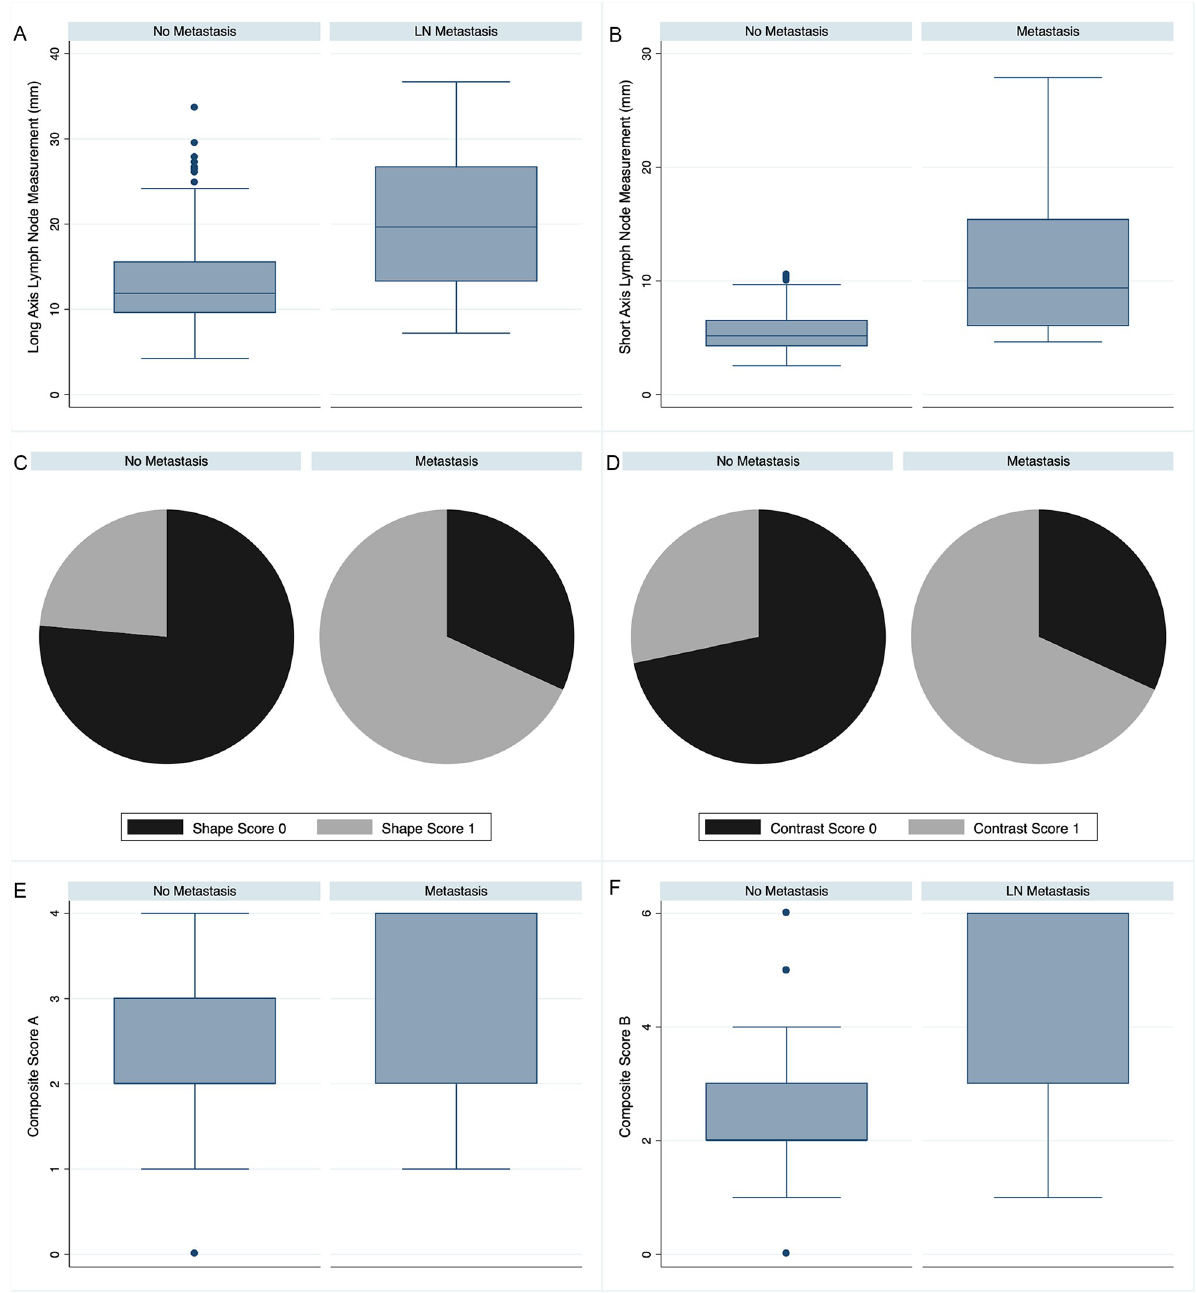
Fig 3. Post-contrast computed tomography (CT) evaluation of cervical lymph nodes (LNs) in dogs with oral tumors. Box and whisker plots demonstrate the median (center line) with the end of the boxes indicating the 25 th and 75 th percentiles and the whiskers indicating the adjacent values of values for post-contrast CT features for metastatic and non-metastatic LNs. Circles indicate outlier values, while pie charts are used for scores that only have two values. Features assessed for differentiation of metastatic from non-metastatic LNs include (A) LN long axis; (B) LN short axis; (C) LN shape score; (D) LN contrast pattern score; (E) Composite Score A; (F) Composite Score B.